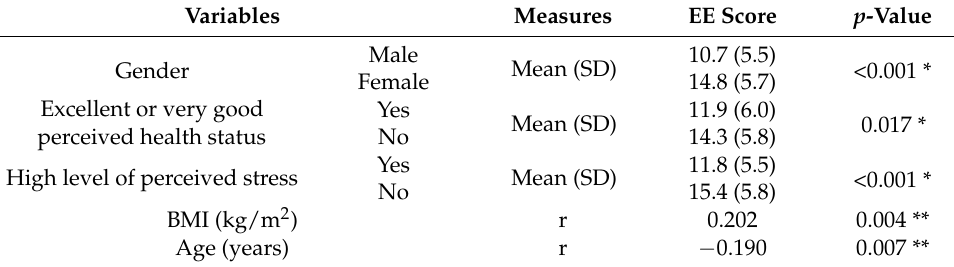
Table 4. Univariate analysis between EE score and selected demographic